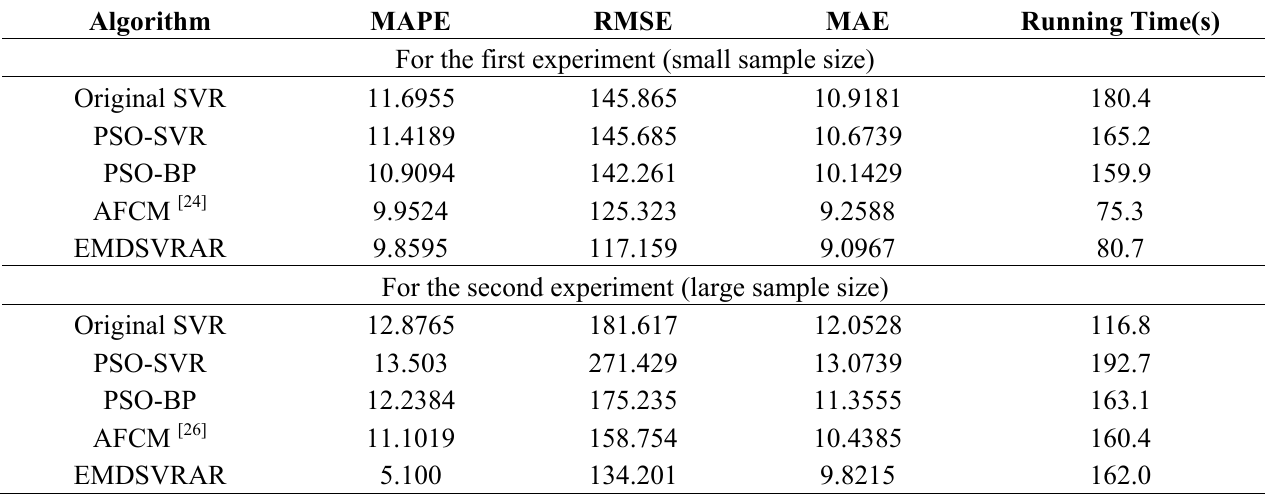
Table 3. Summary of results of the forecasting